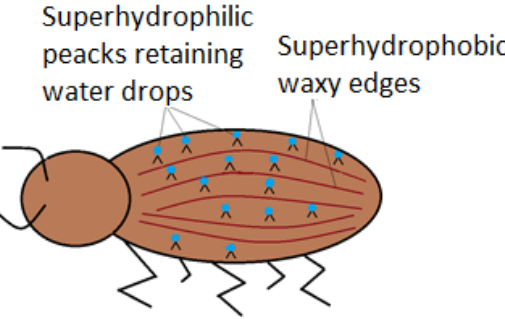
Figure 5. Namib desert beetle displaying superhydrophobic edges and superhydrophilic back